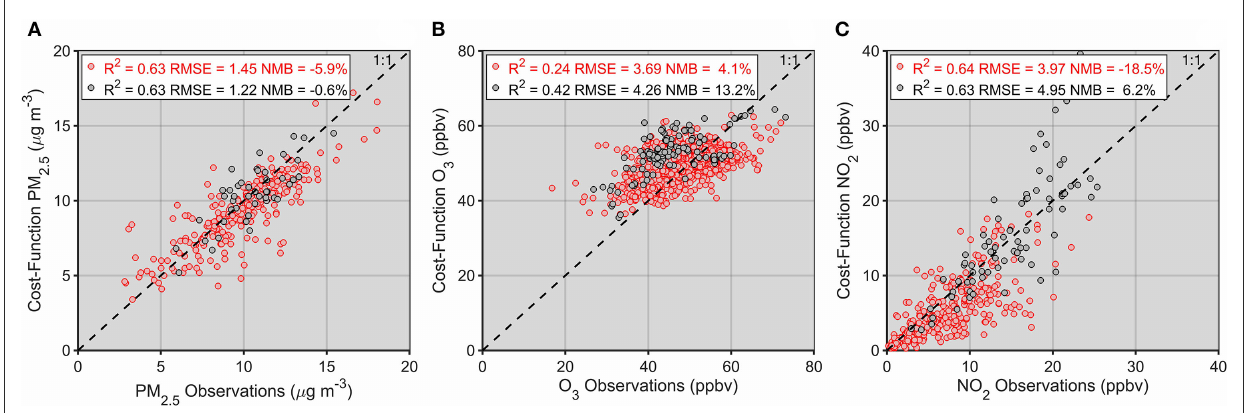
FIGURE2 Evaluation of the exposures of PM 2.5 (A) , O 3 (B) , and NO 2 (C) compared to US EPA AQS observations. Results for monitors across the entire domain are given in red while comparisons for only the study cities are given in gray.